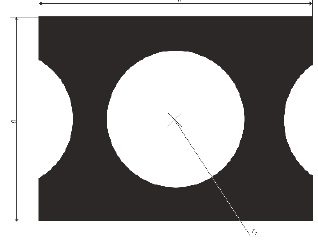
Fig. 3. A fragment of the matrix of round marks in the field of view of the recording device: h is the distance between the centres of round marks in the lines and columns of the matrix; r t is the radius of the round mark; a and b are the smaller and larger sides of the rectangular field of view of the recording device, respectively; R CAM is the resolution of the recording device.